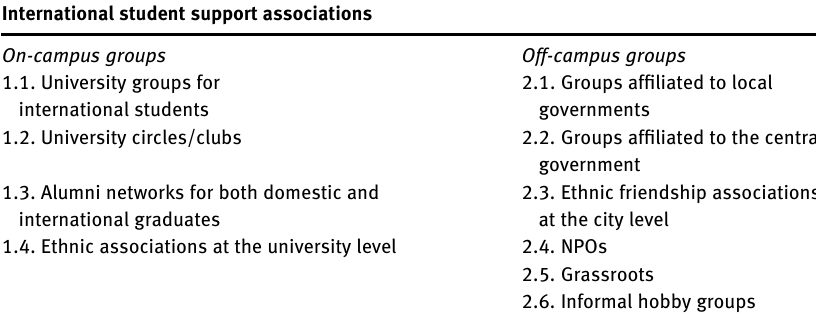
Table  : International student support associations in the Kansai area of